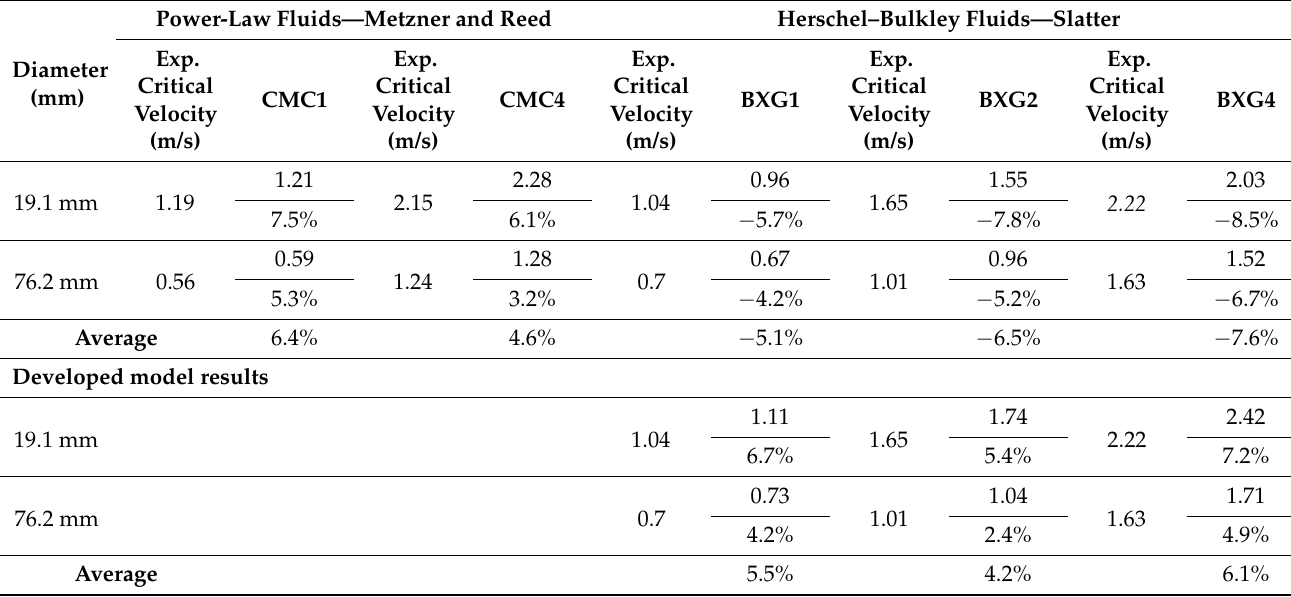
Table 3. Transitional velocity model